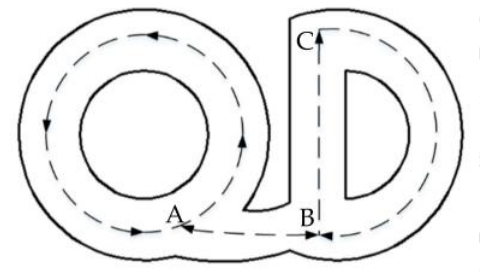
Figure 16. Diagram of scanning trajectory.